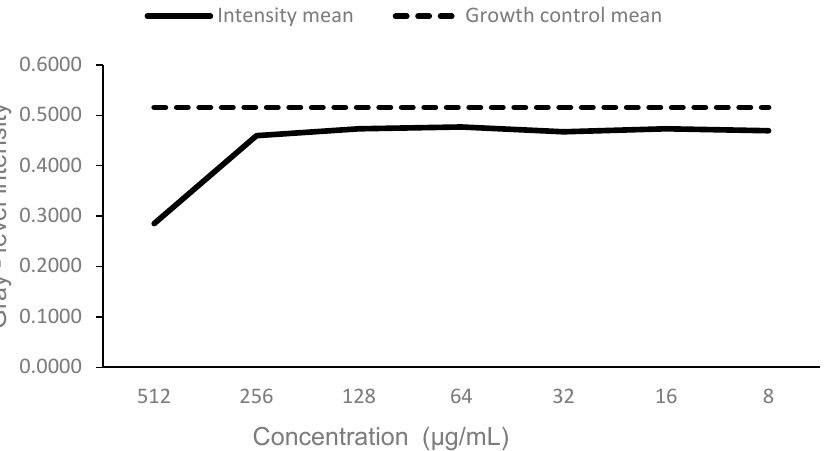
Figure 4. Graph representing the growth inhibition curve (GIC) and the maximum growth of the 1199B strain before the addition of resazurin.